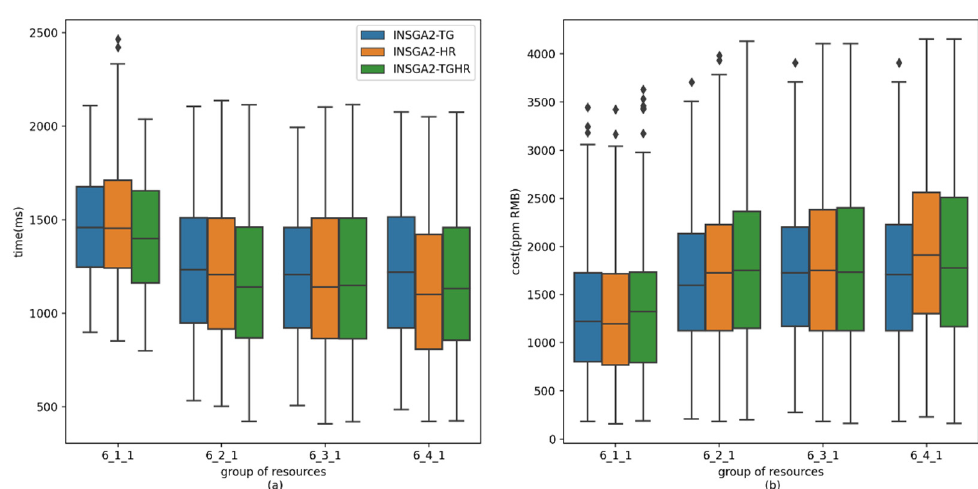
Figure 12. The boxplot in different edge resources setting. ( a ) Comparing the effect of edge resources setting on time; ( b ) Comparing the effect of edge resources setting on cost.